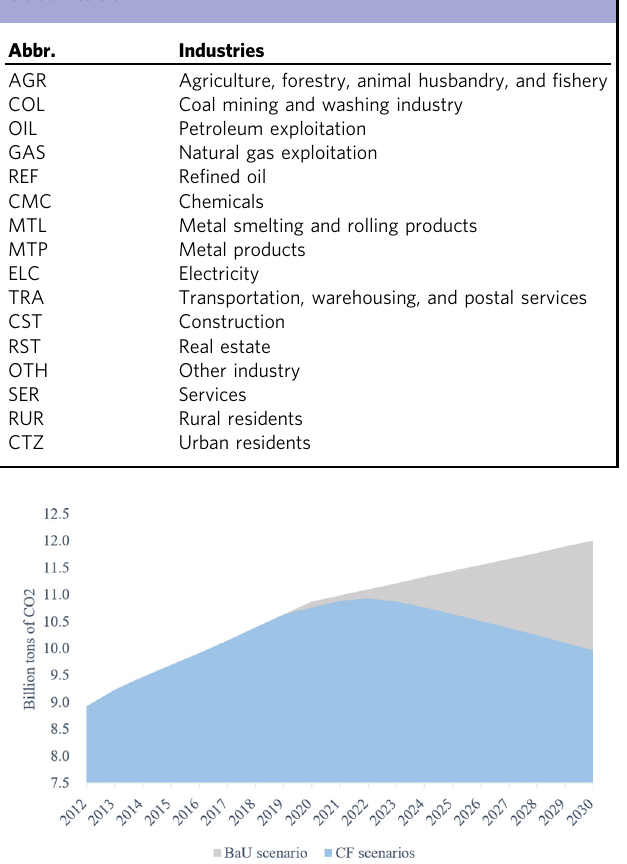
Table 2 Description of industry classi fi cation and population classi fi cation.